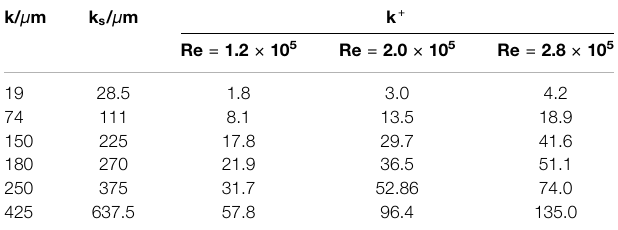
TABLE 2 | Blade roughness